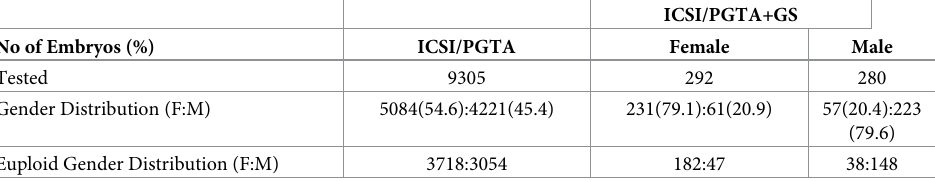
Table 4. Ploidy of tested embryos for the control and study groups according to